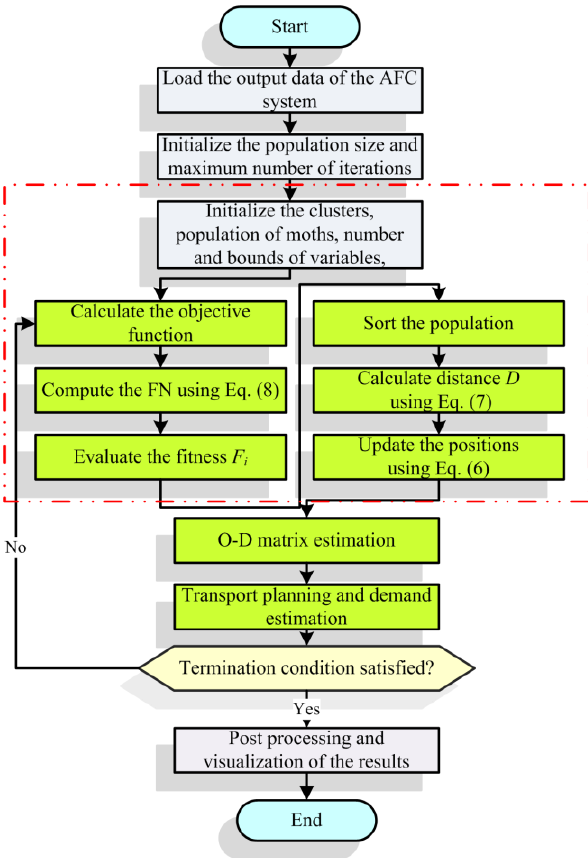
Figure 1. Flowchart of the proposed MFOSGA approach In Table 1, the best, worst, average, median and the standard deviation (STD) of solutions for each algorithm is reported in detail.